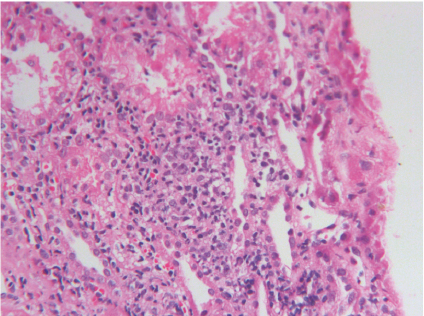
Figure 3: Photomicrographshowing dense chroniclymphoplasma- cytic interstitial inflammation (H&E X 160).